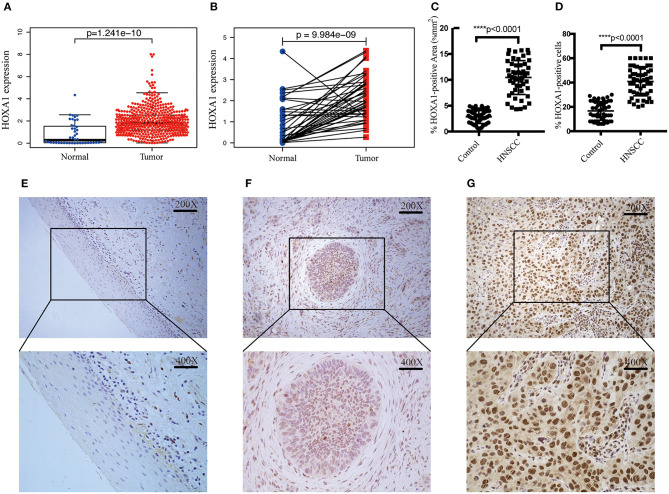
Transcriptional expression and protein level of HOXA1 is significantly high in HNSCC patients. (A) Higher HOXA1 mRNA expression in 499 tumor tissues compared with 43 para-carcinoma tissues based on TCGA-HNSC DATA (p = 1.241e−10). (B) Paired difference analysis of HOXA1 mRNA expression based on TCGA-HNSC DATA (p = 9.984e−09). (C) The percentage of HOXA1-positive area was significantly higher in HNSCC sections than in para-carcinoma sections (P < 0.0001). (D) The percentage of HOXA1-positive cells was significantly higher in HNSCC sections than in para-carcinoma sections (P < 0.0001). (E–G) Representative immunohistochemical staining for HOXA1 protein in 52 matched HNSCC tissues and para-carcinoma tissues. (E) Negative expression of HOXA1 in para-carcinoma tissues (−). (F) Low expression of HOXA1 protein in HNSCC specimens (− to +). (G) High expression of HOXA1 protein in primary HNSCC specimens (++). Original magnification: x200 (top), x400 (bottom).